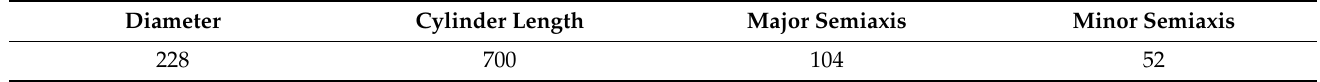
Table 2. Geometric parameters of composite pressure vessel (unit mm).